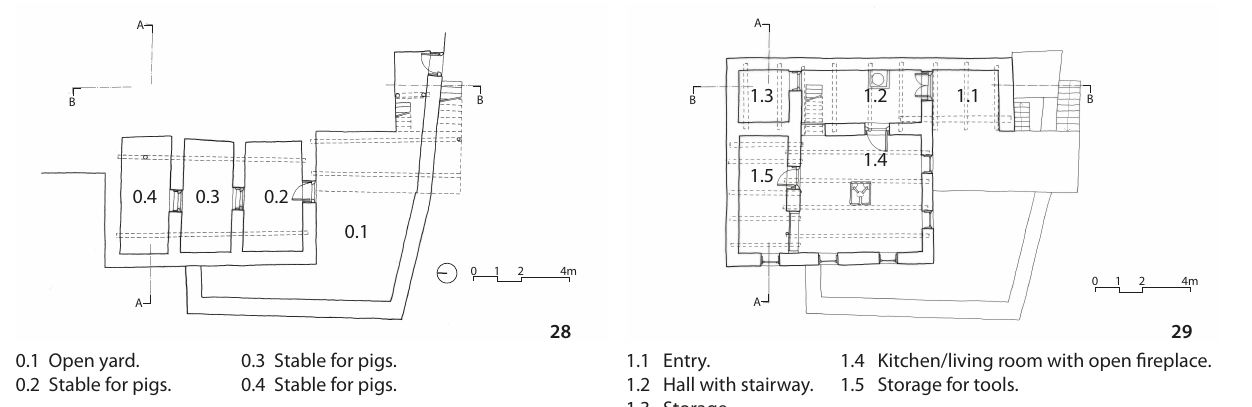
Figure 28 Ground floor plan of the farmhouse in Gyalrong (Source: the authors).